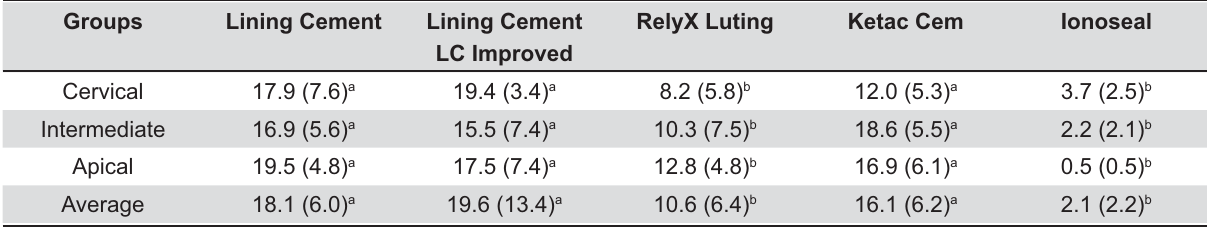
Same lowercase letters (rows) indicate absence of difference by two-way ANOVA test ( α